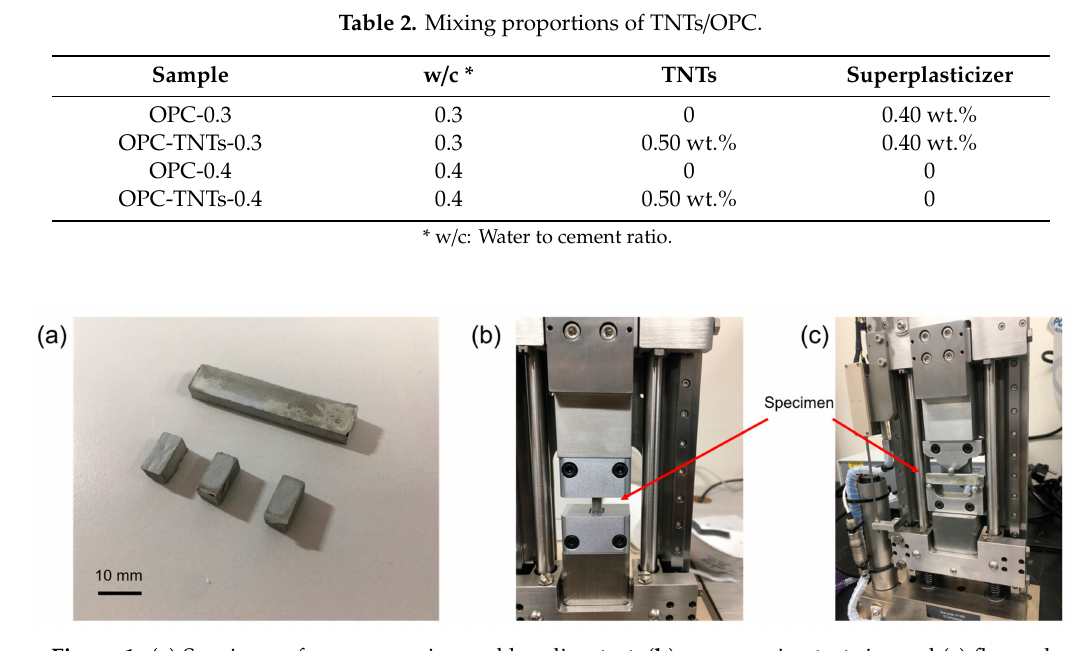
Figure 1. ( a ) Specimens for compressive and bending test, ( b ) compressive test rig, and ( c ) flexural test